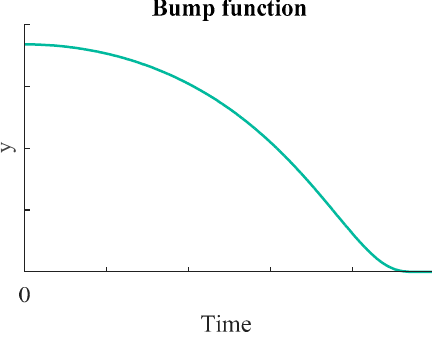
Figure 4. Feature of the bump function.